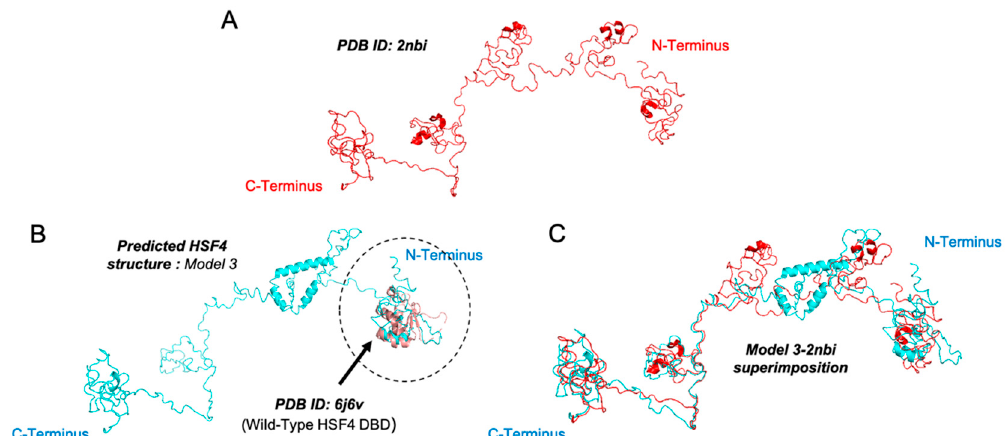
Figure 4. HSF4 3D-structure as predicted by I-TASSER. ( A ) I-TASSER predicted 2nbi as the closest HSF4 analog. The superimposition of the predicted HSF4 structure model 3 with the ( B ) previously resolved wild-type HSF4 DNA binding domain structure (Protein Databank (PDB) ID: 6j6v) and ( C ) its closest analog 2nbi.